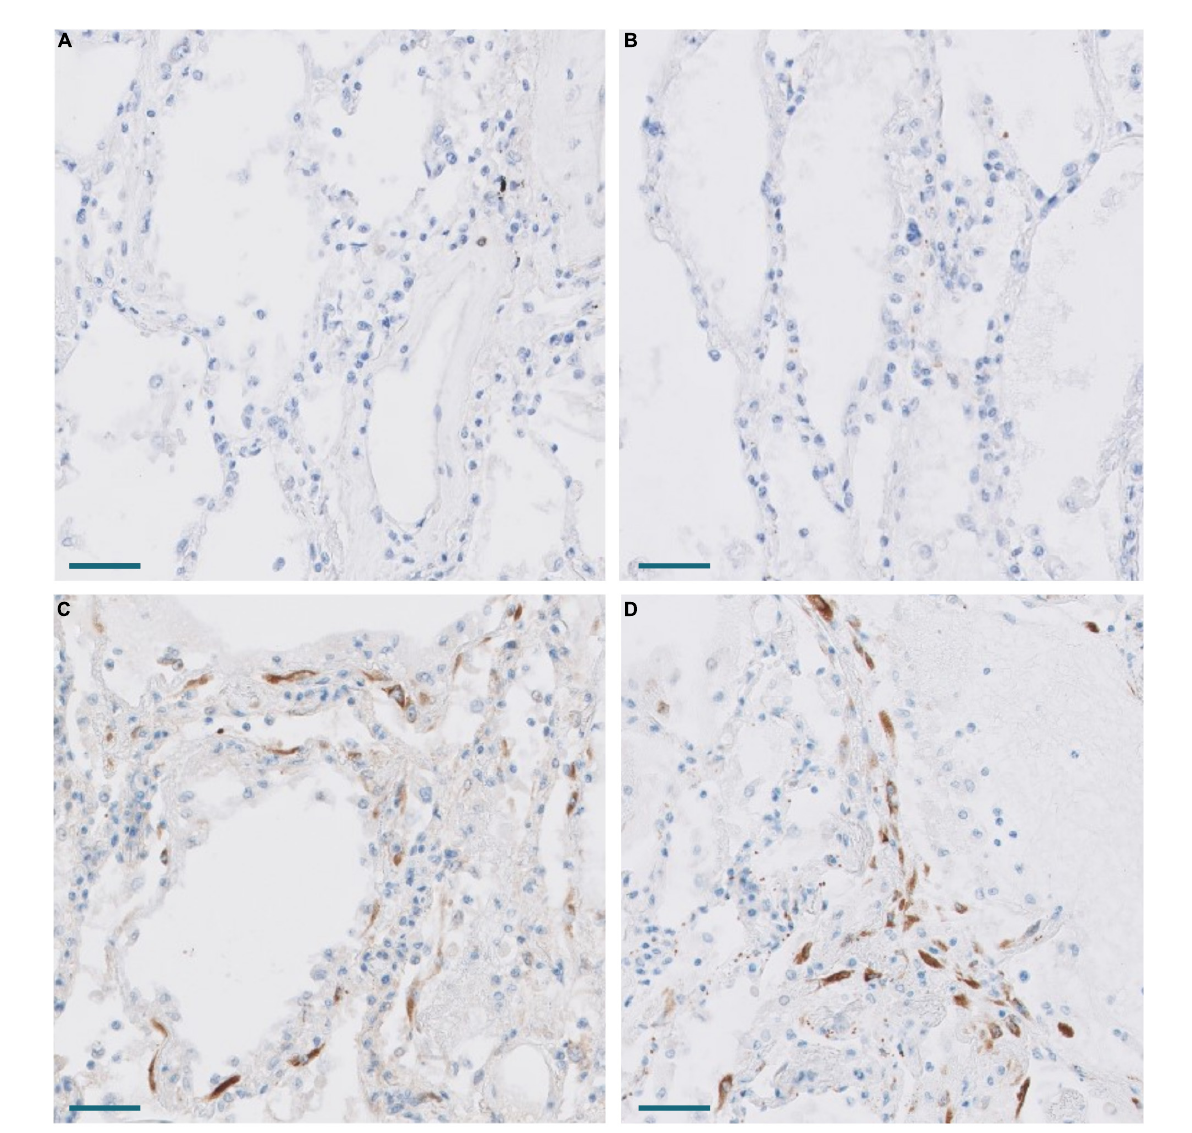
FIGURE7 Expression of CTHRC1 and SPARC in the lung of Pt. 3 with 13 days evolution. (A,B) No expression of CTHRC1 and SPARC in normal lung areas. Scale bar: 100 µ m. (C,D) CTHRC1 (C) and SPARC (D) expression in interstitial fibroblasts in areas with early exudative diffuse alveolar damage. Scale bar: 100 µ